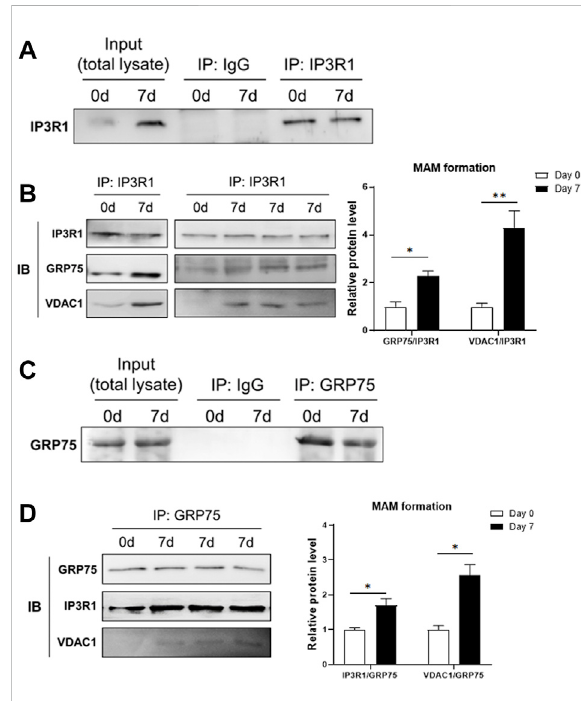
FIGURE 2 Increase of MAMs formation after adipogenic differentiation. (A,B) Protein lysates from 3T3-L1 preadipocytes (Day 0) and adipocytes (Day 7 after differentiation) were pulled down by an anti-IP3R1 antibody (A) and followed by detection of GRP75 and VDAC1 proteins using Western blot analysis (B, right panel). The MAMs formation was calculated by the ratio of interaction between IP3R1 and GRP75 and between IP3R1 and VDAC1, respectively (B, left panel). N = 3 in each group. (C,D) Protein lysates from 3T3-L1 preadipocytes (Day 0) and adipocytes (Day 7 after differentiation) were pulled down by an anti-GRP75 antibody (C) and followed by detection of IP3R1 and VDAC1 using Western blot analysis (D, right panel). The MAMs formation was calculated by the ratio of interaction between GRP75 and IP3R1 and between GRP75 and VDAC1, respectively (D, left panel). N = 3 in each group. Data are presented as means ± SEM.; * p < 0.05; ** p <